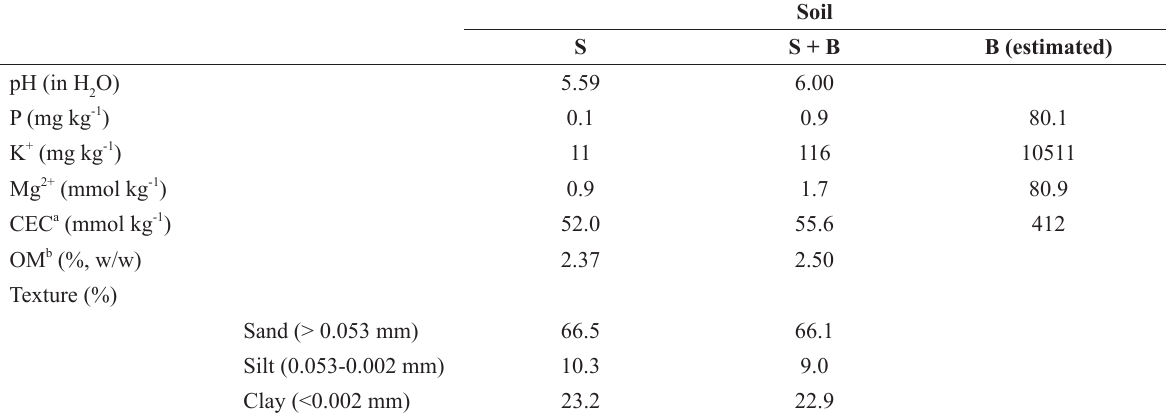
Physicochemical characteristics of soil (S) and soil amended by 1% of biochar in particle size <106 µm (S +